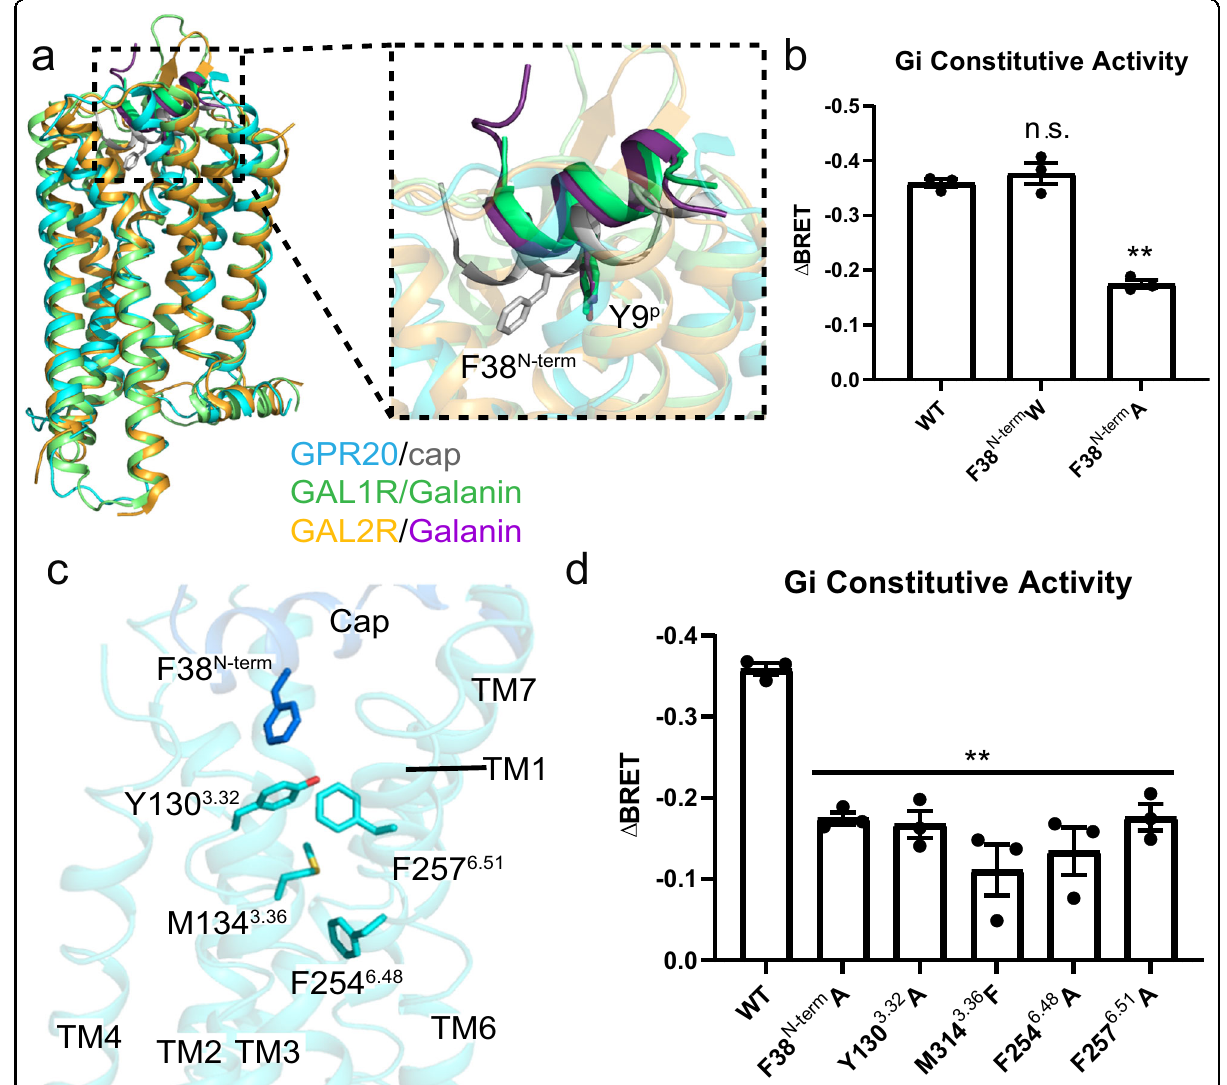
Fig. 3 The activation mechanism of GPR20. a Left, structural superposition of the ligand-free GPR20-Gi, galanin-bound GAL1R-Gi (PDB 7WQ3) and galanin-bound GAL2R-Gq (PDB 7WQ4) structures. Right, magni fi ed view of the N-terminal cap of GPR20 (gray), galanin in GAL1R (green) and galanin in GAL2R (purple). Key residues are shown as sticks. b Constitutive activities of WT GPR20 and F38 mutations are measured by BRET assay. Δ BRET: the change of bioluminescence resonance energy transfer value (Materials and methods). Signi fi cance was determined by two-way analysis of variance (ANOVA) without repeated measures, followed by Dunnett ’ s post hoc test (** P < 0.01, n.s., not signi fi cant). Data are mean ± s.e.m. ( n = 3